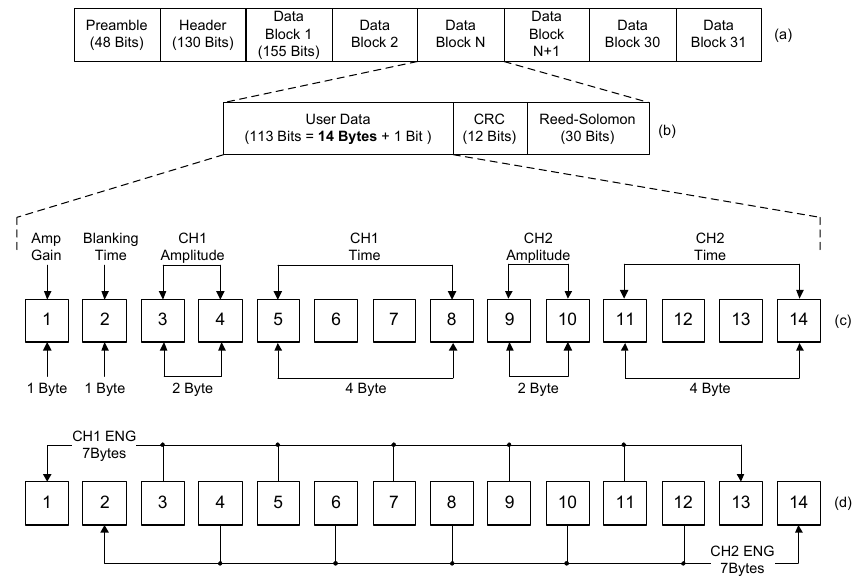
Figure 7. Block diagram of the proposed data packet and its structure: ( a ) data packet, ( b ) data block, ( c ) user data section for commands and ( d ) user data section for acquired neural signals.